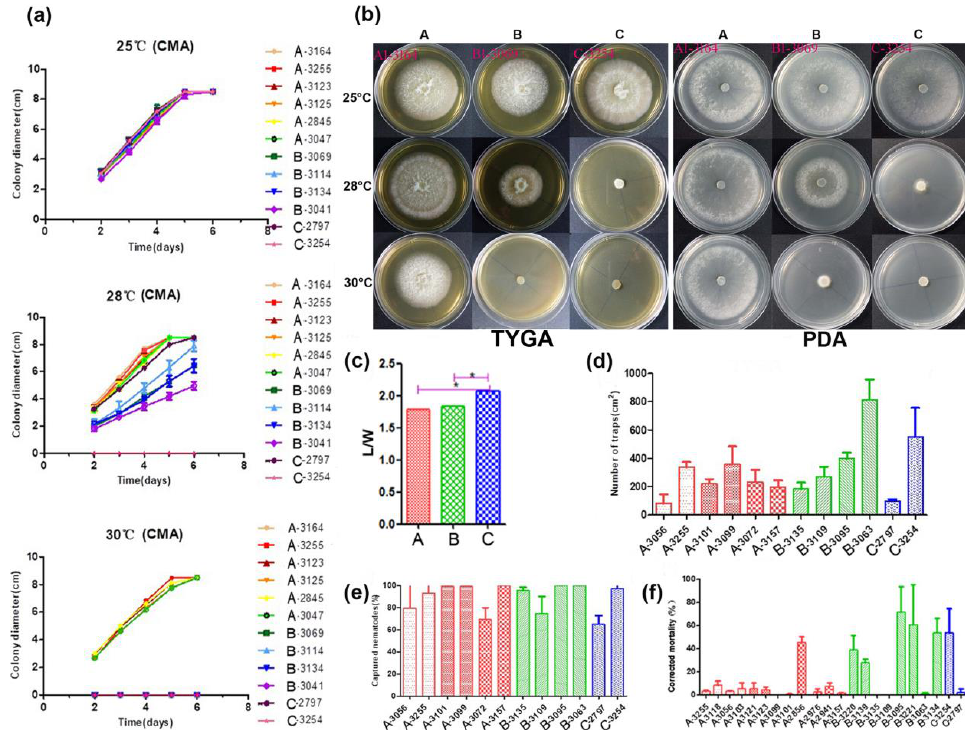
Figure 6. Phenotypical characterization of strains from the three main lineages. ( a ) The growth state of 12 representative A. oligospora strains incubation at 25, 28, and 30 ◦ C on CMA. ( b ) Colony morphology of representative strains at 25, 28, and 30 ◦ C on TYGA and PDA plates. ( c ) Pairwise comparisons of L/M among representative strains. ( d ) Comparison of trap formation, ( e ) captured nematodes, and ( f ) nematicidal activities of fermentation broth among representative strains. Notes: CMA: corn meal agar, TYGA: the tryptone, yeast extract, and glucose agar, PDA: potato dextrose agar, * significantly different.